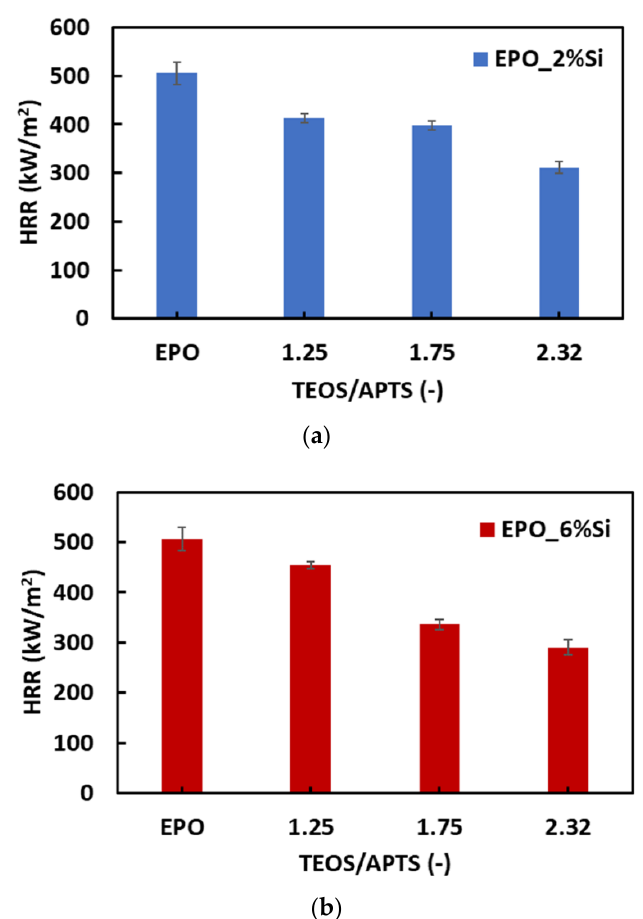
Figure 6. HRR vs. TEOS/APTES molar ratio for the two investigated series containing ( a ) 2 wt.% of silica and ( b ) 6 wt.% of silica. silica and ( b ) 6 wt.% of